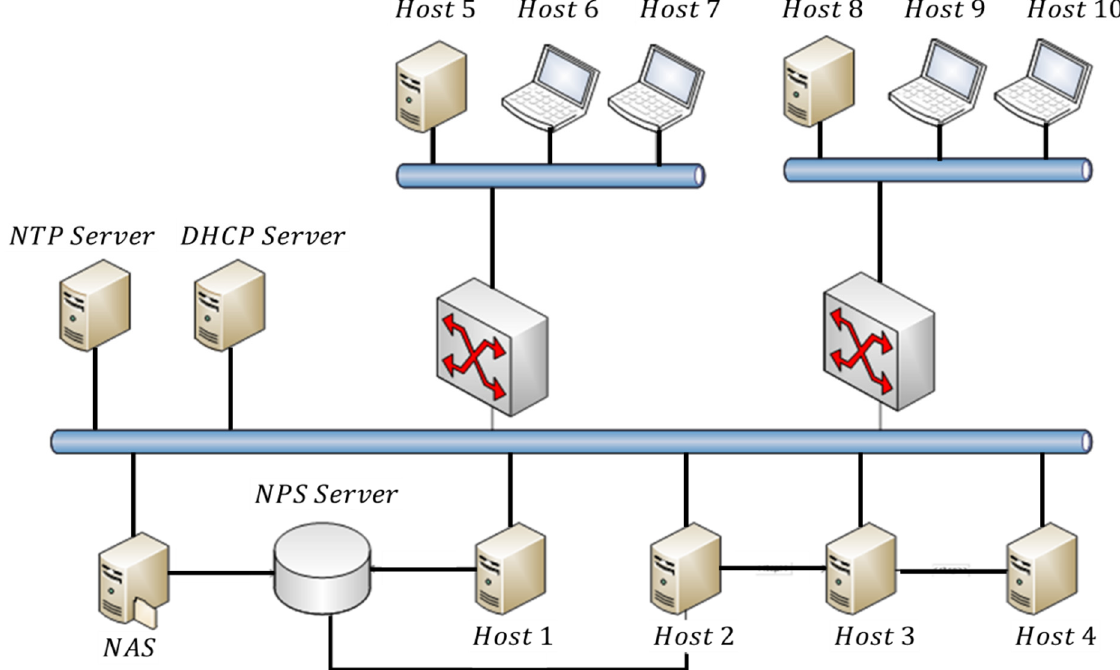
Figure 4. Network-topology schematization of the considered case study.